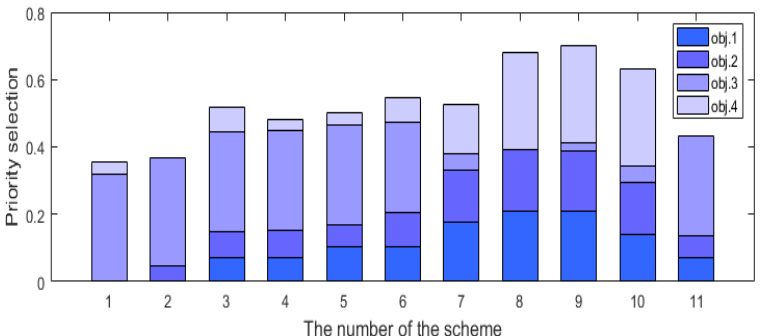
Figure 8. The priority selection of each scheme.